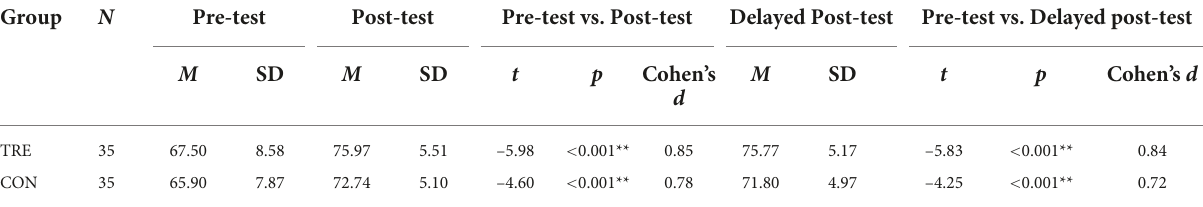
TABLE 6 Paired samples t -tests of holistic writing scores in the pre-, post-, and delayed post-tests for the treatment and control groups. Group N